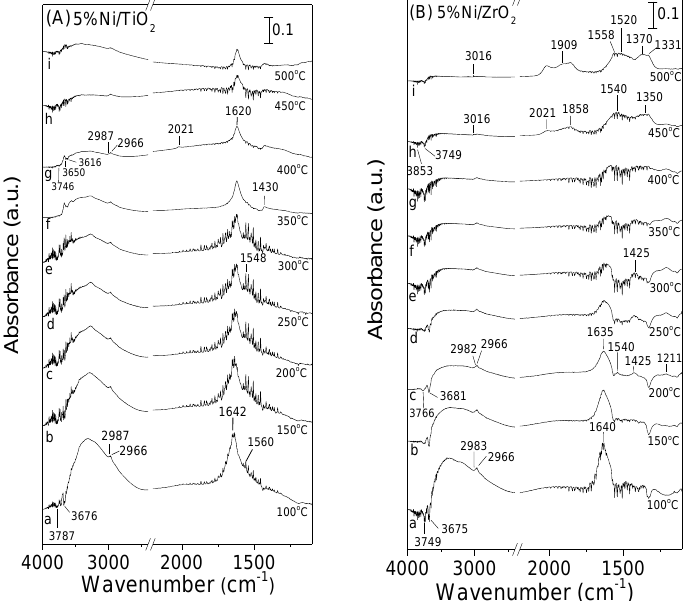
Figure 7. DRIFT spectra obtained over the ( A ) Ni/TiO 2 and ( B ) Ni/ZrO 2 catalysts following interaction with 0.5% C 3 H 8 + 5% H 2 O (in He) at 100 °C for 15 min and subsequent stepwise heating at 500 °C.